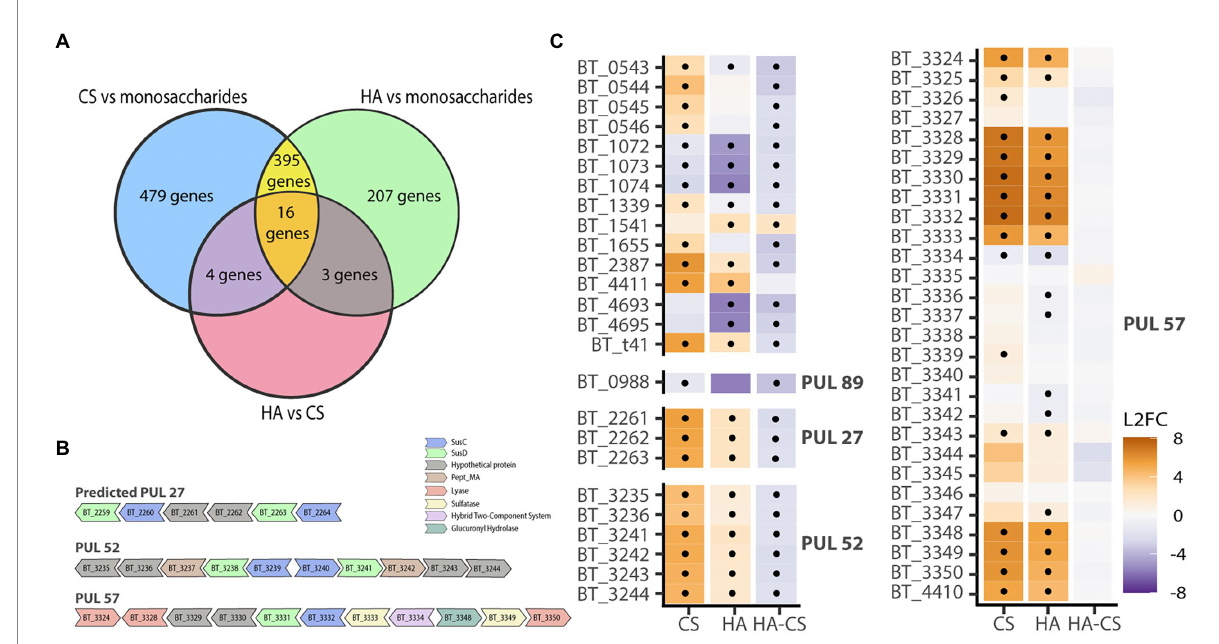
FIGURE 2 Transcriptomics does not indicate a separate pathway for HA degradation. B . theta was grown on either CS, HA or a control mix containing GalNac, GlcNac or GlcA. (A) Venn diagram showing overlapping differentially expressed genes in the different growth conditions. (B) Polysaccharide Utilization Loci (PUL) containing differentially expressed genes for CS and/or HA. (C) Heatmap showing log 2 fold change (L2FC) for CS – mix, HA-mix or HA compared with CS. Genes are grouped by PULs. PUL57 is the known PUL for CS & HA degradation and does not differ for CS or HA. Dots indicate statistically significant genes ( p < 0.05 and L2FC of either ≥ 2 or ≤ −